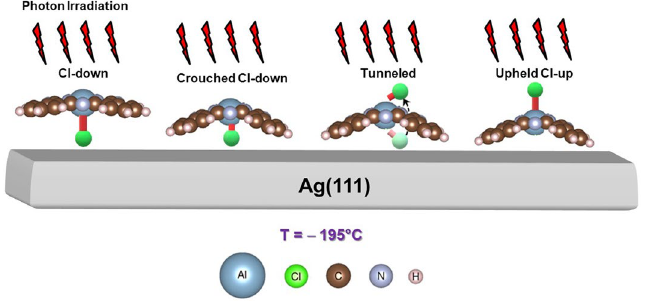
Figure 4. Schematic illustration of the proposed optomechanical model for the tunneling of the Cl atom through the Pc plane of ClAlPc to complete the switchover from Cl-down to upheld Cl-up configuration under photon